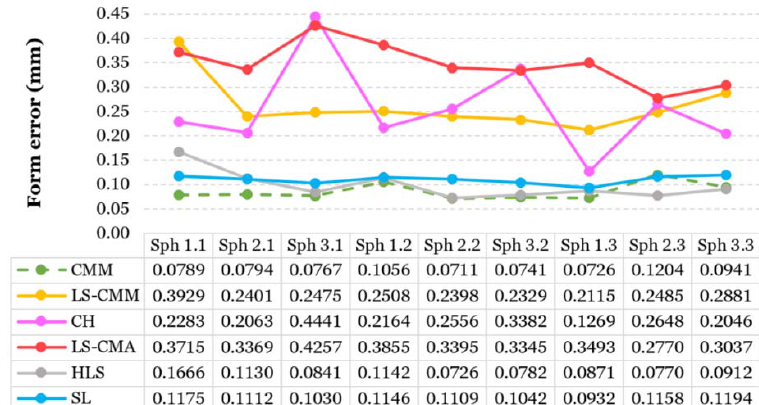
Figure 8. Contact and optical measurements of sphere form error.